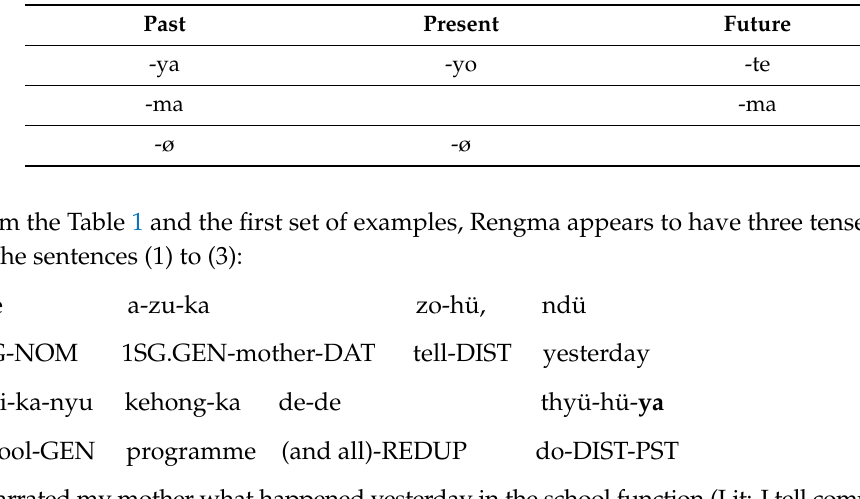
Table 1. Tense marking in Rengma.